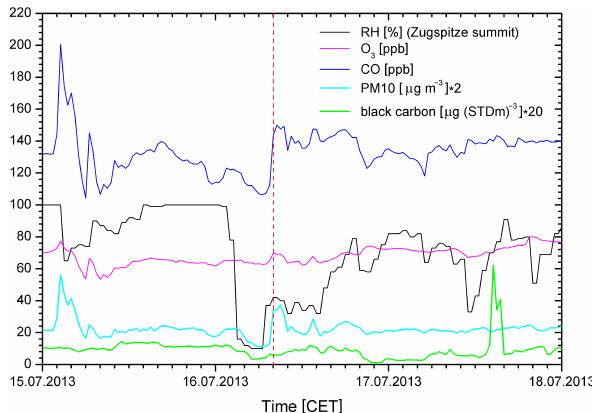
Figure 19. Selected measurements at UFS between 15 and 17 July 2013. The dashed vertical line (09:00CET) marks the ar- rival of the edge of the smoke layer at the station. The relative- humidity data are taken from the listings of the German Weather Service (DWD) at the Zugspitze summit located 0.3km higher than UFS. The dry smoke layer was observed earlier